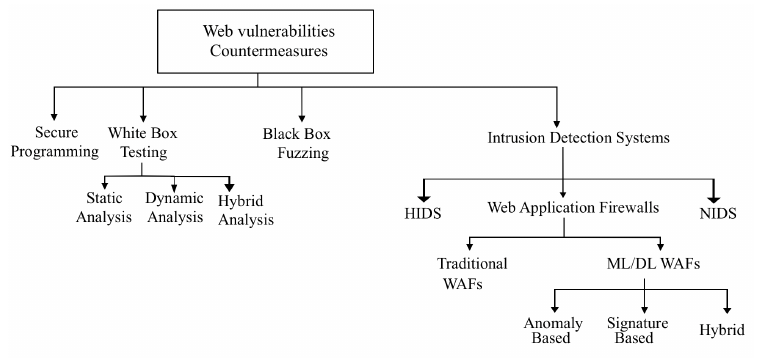
Figure 3. Web vulnerabilities